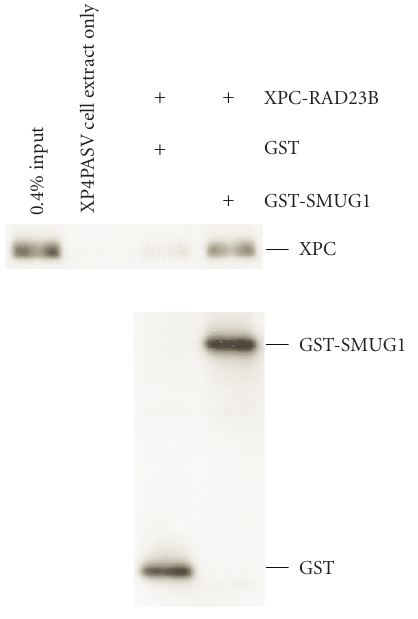
Figure 7: XPC interacts physically with SMUG1 in vitro . Glutathione-Sepharose beads (20 μ l) were incubated in 100 μ l of the binding mixture with 10 nM of either GST or GST-TDG in the presence of the same concentration of XPC-RAD23B. After extensive washing, bound proteins were eluted with bu ff er con- taining 10 mM glutathione. One-fourth of each eluate was mixed with whole cell extract from XP4PASV cells which do not express XPC and subjected to 8% SDS-PAGE followed by immunoblotting with anti-XPC antibody (upper panel). The same samples were also subjected to 12% SDS-PAGE followed by immunoblotting with anti-GST antibody (lower